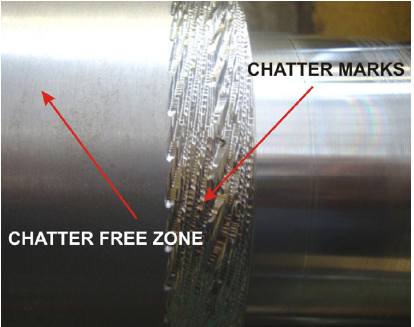
Figure 1. An example of a surface after machining with self-excited vibrations.